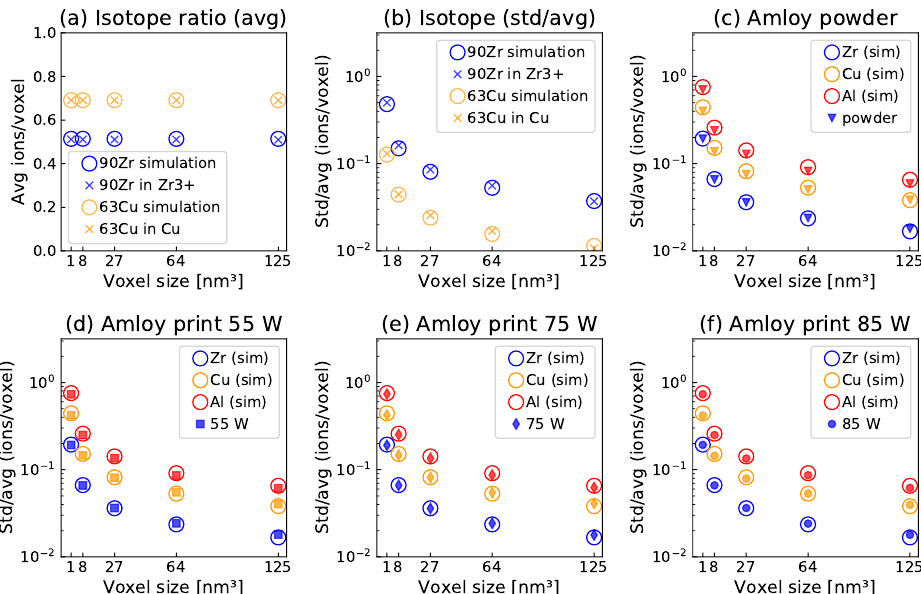
Figure 1. ( a , b ): Local 90 Zr and 63 Cu isotope distribution in pure zirconium and copper: mean ( a ) and std/avg ( b ) of the local isotope concentration versus voxel size in nm 3 . For Zr, only Zr 3+ ions are considered due to ambiguity related to ZrH complex ions for other charge states. ( c – f ) APT measurements for Amloy powder ( c ) and printed parts ( d – f ). Std/avg for the local elemental concentrations of the main alloy components Zr, Cu, and Al versus voxel size in nm 3